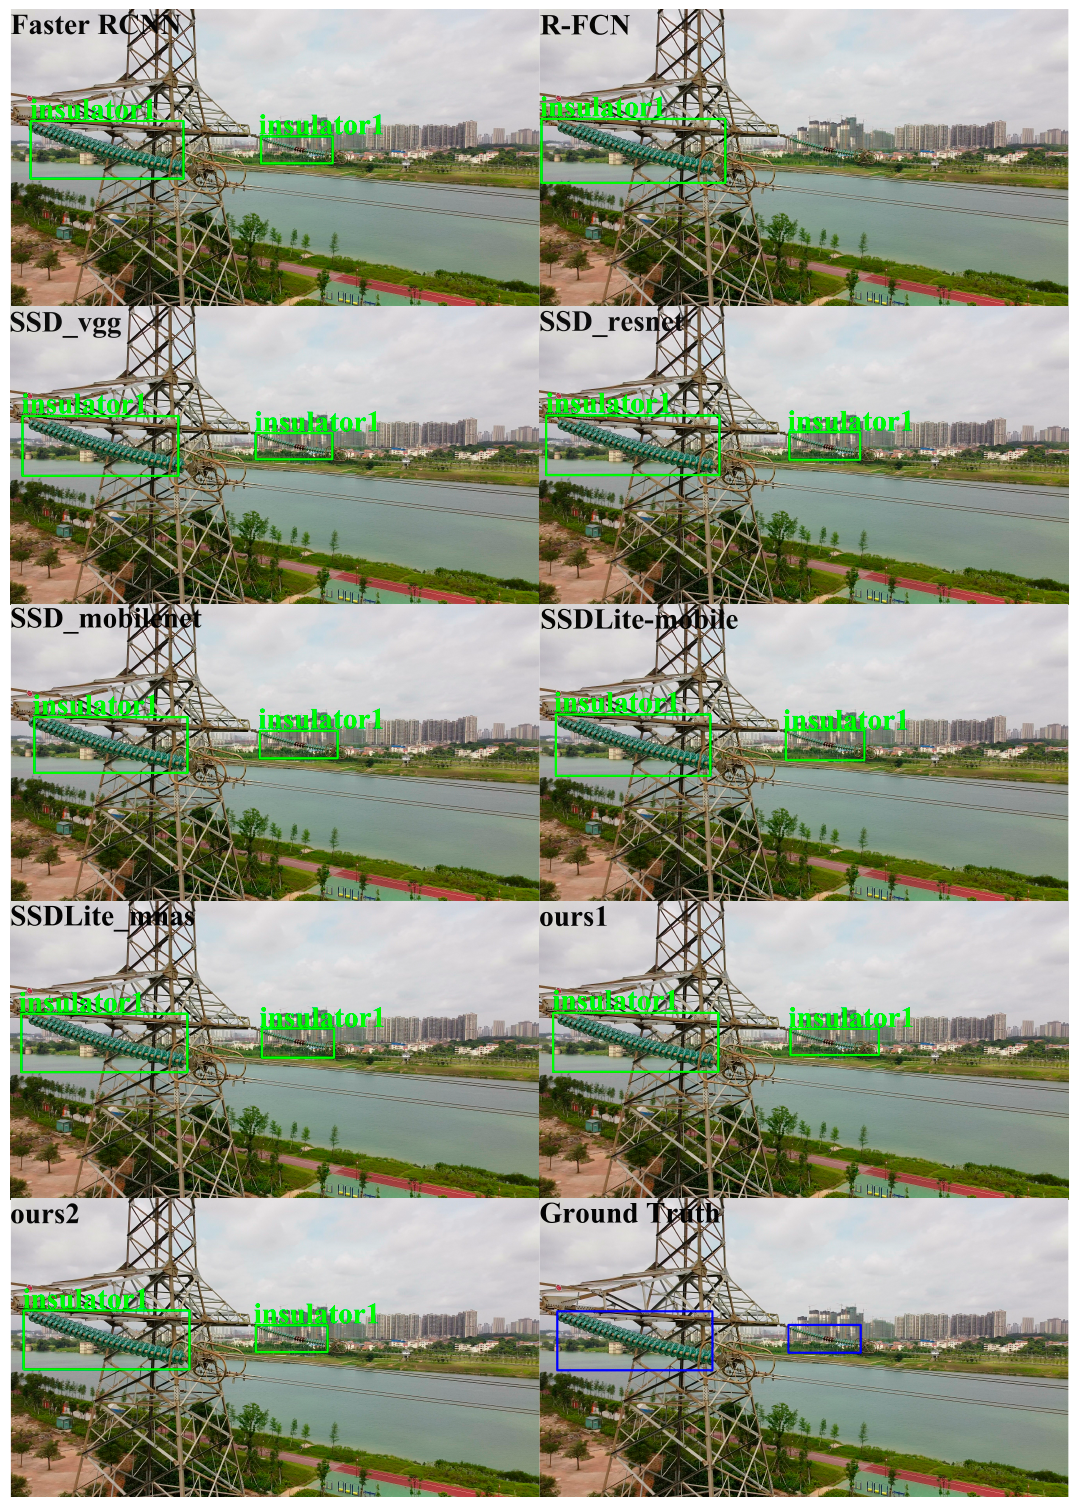
Figure 9. Insulator1 detection results. The blue box is the ground truth of the position of insulator1 in the image.